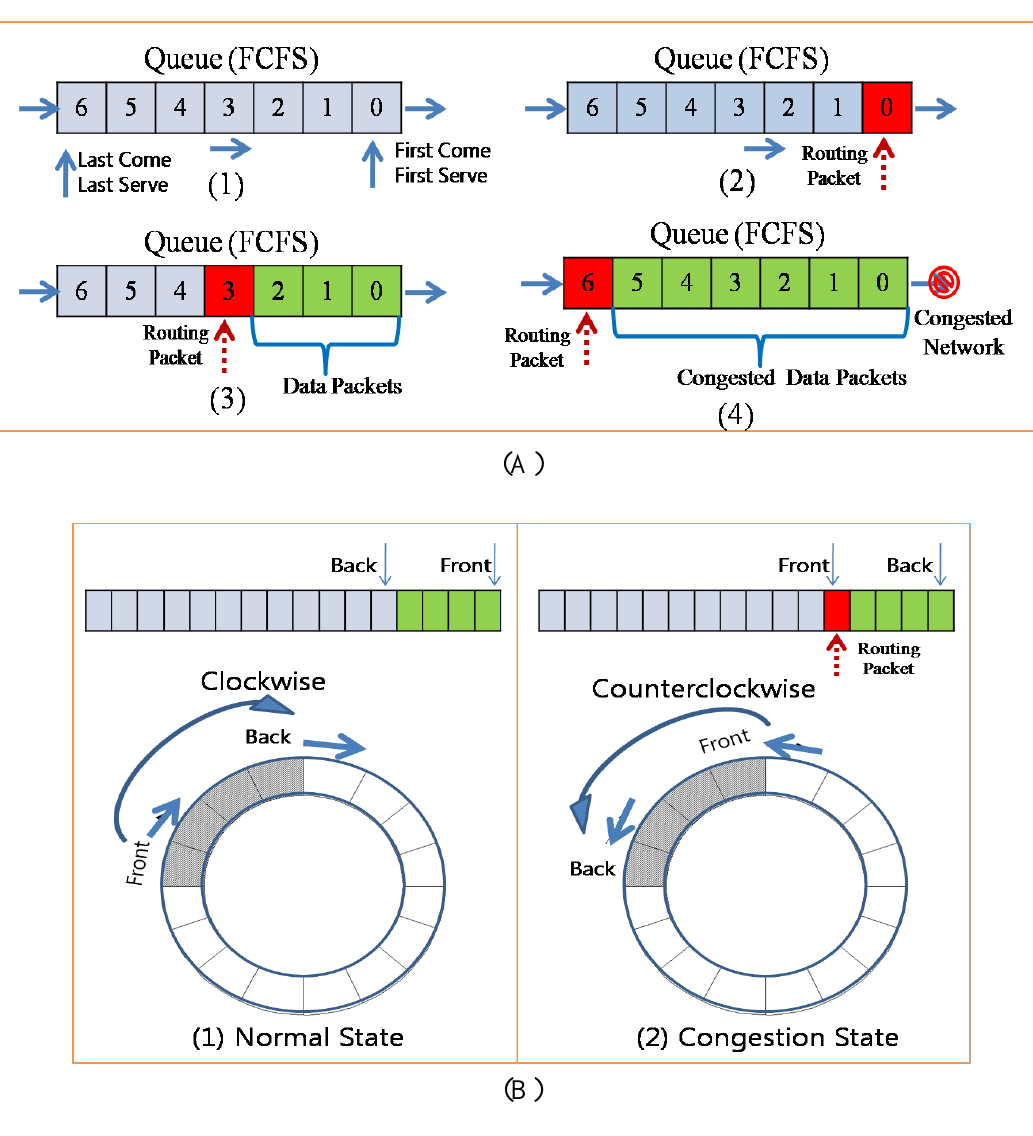
Figure 10. Queue operation in